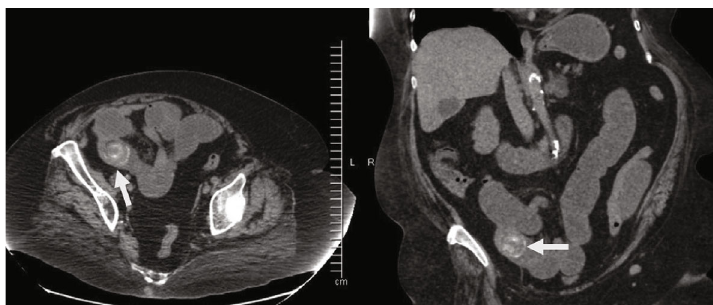
Figure 1: CT scan demonstrating large gallstone (white arrow) causing a small bowel